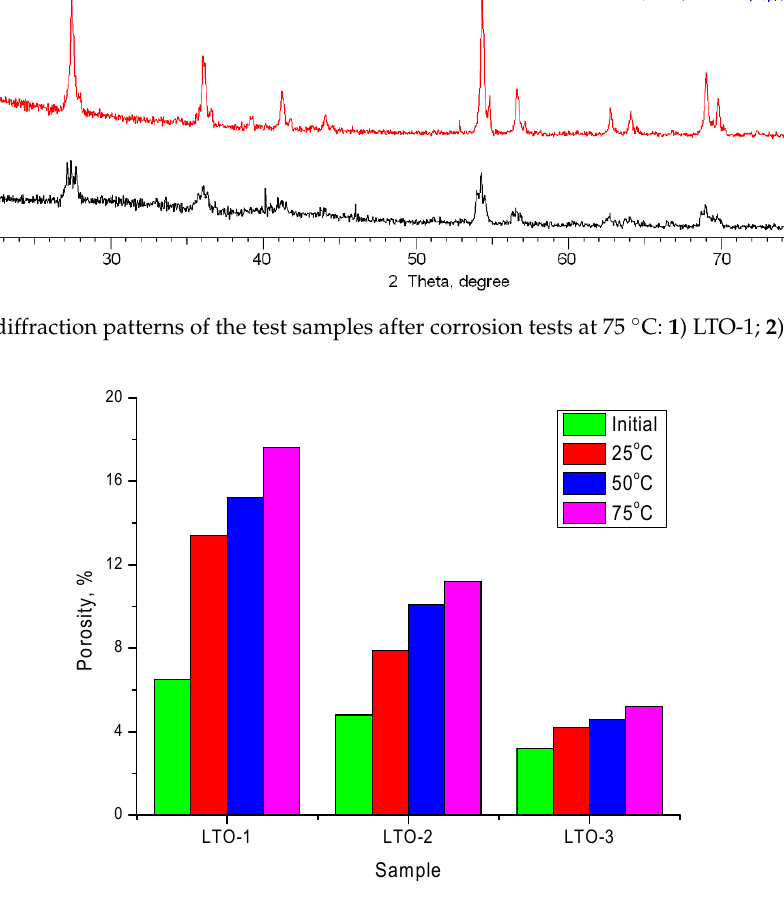
Figure 7. Results of change in ceramic porosity depending on exposure conditions.